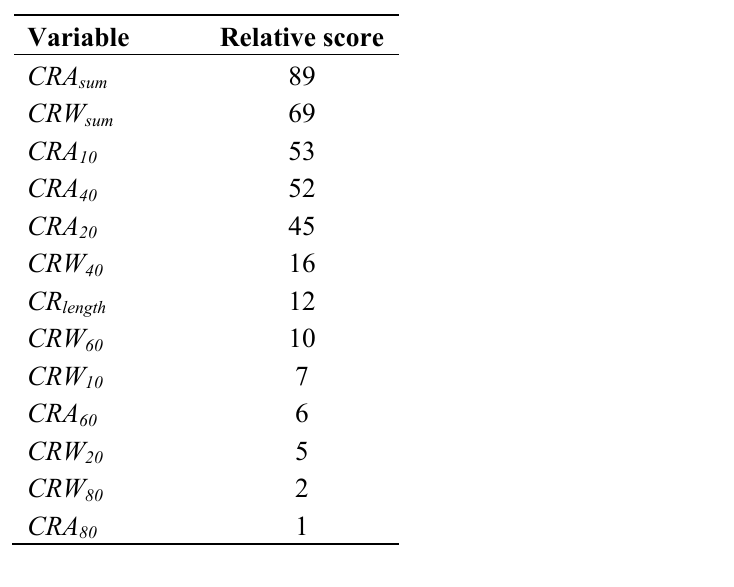
Table 3. Ranking of the TLS-derived variables. The importance score based on the ―out-of-bag‖ predictions in the random forest model; here, given relative to the lowest ranked variable, which was given the value of one.